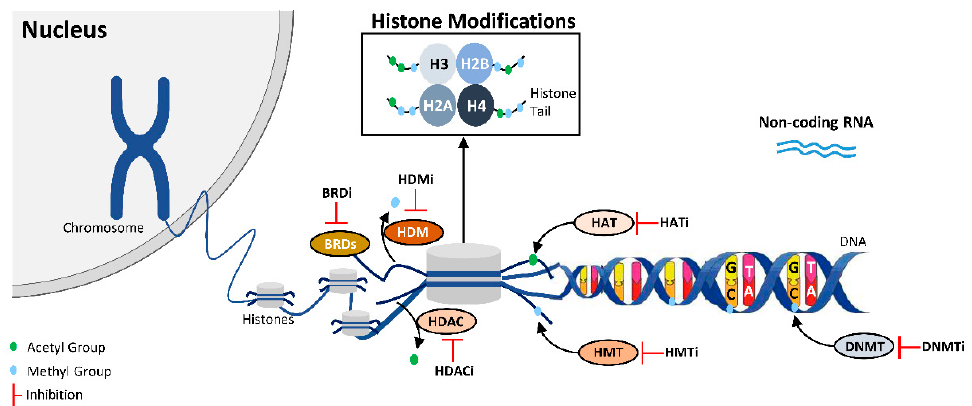
Figure 1. Epigenetic Mechanisms and Epigenetic Inhibitors. This figure illustrates the epigenetic enzymes responsible for DNA and Histone Modifications, along with illustrative inhibitors classified according their epigenetic target.